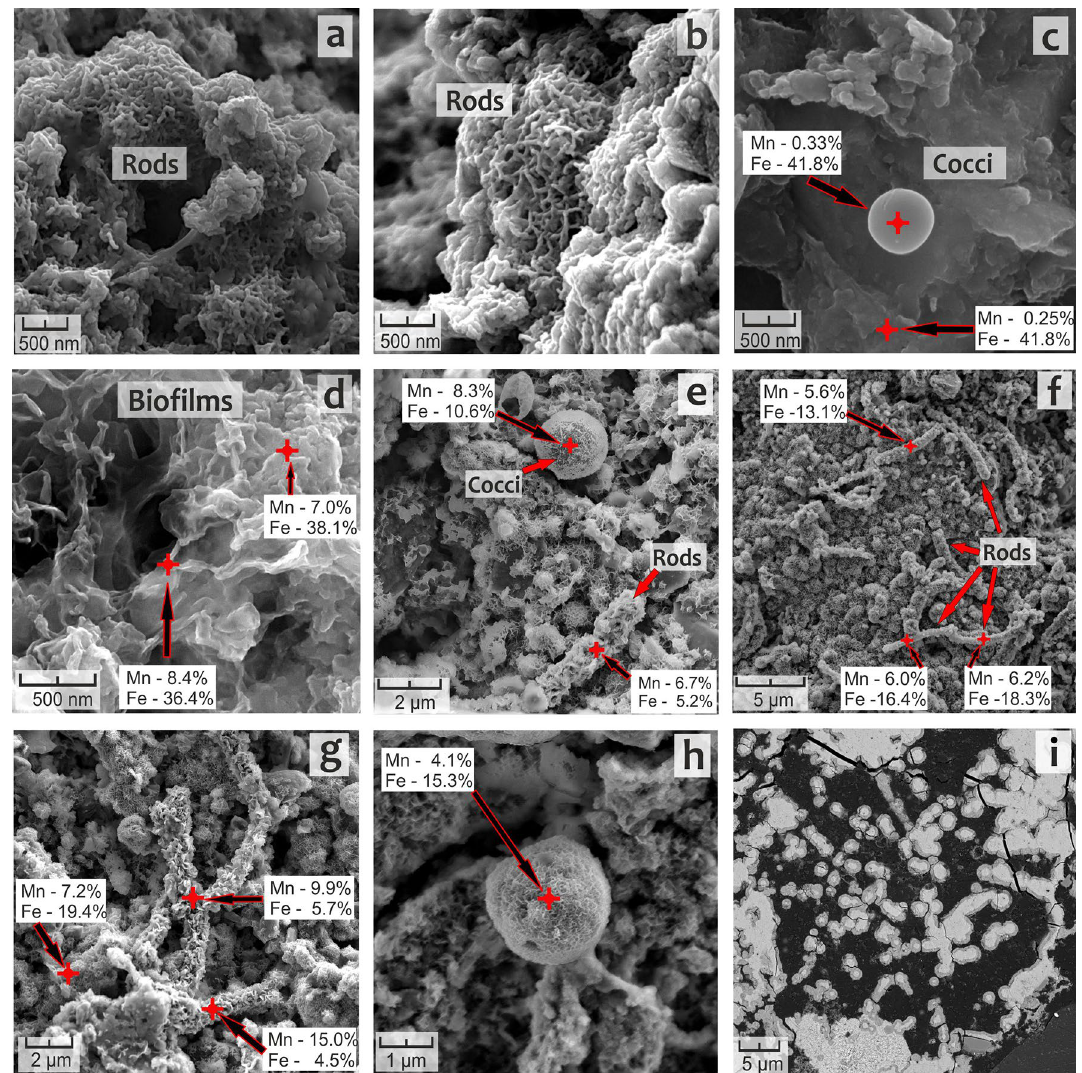
Figure 3. SEM images of ( a–d ) Fe-rich nodule (site PSh128.35) (central part of the nodule); ( e–h ) Mn-rich nodule (site AMK76-6259) (central part of the nodule); ( i ) laminated microtexture surrounding the globular structures which have the dimensions of coccoid